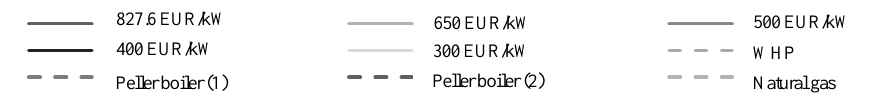
Fig. 4. Comparison of different heating systems and solar collector